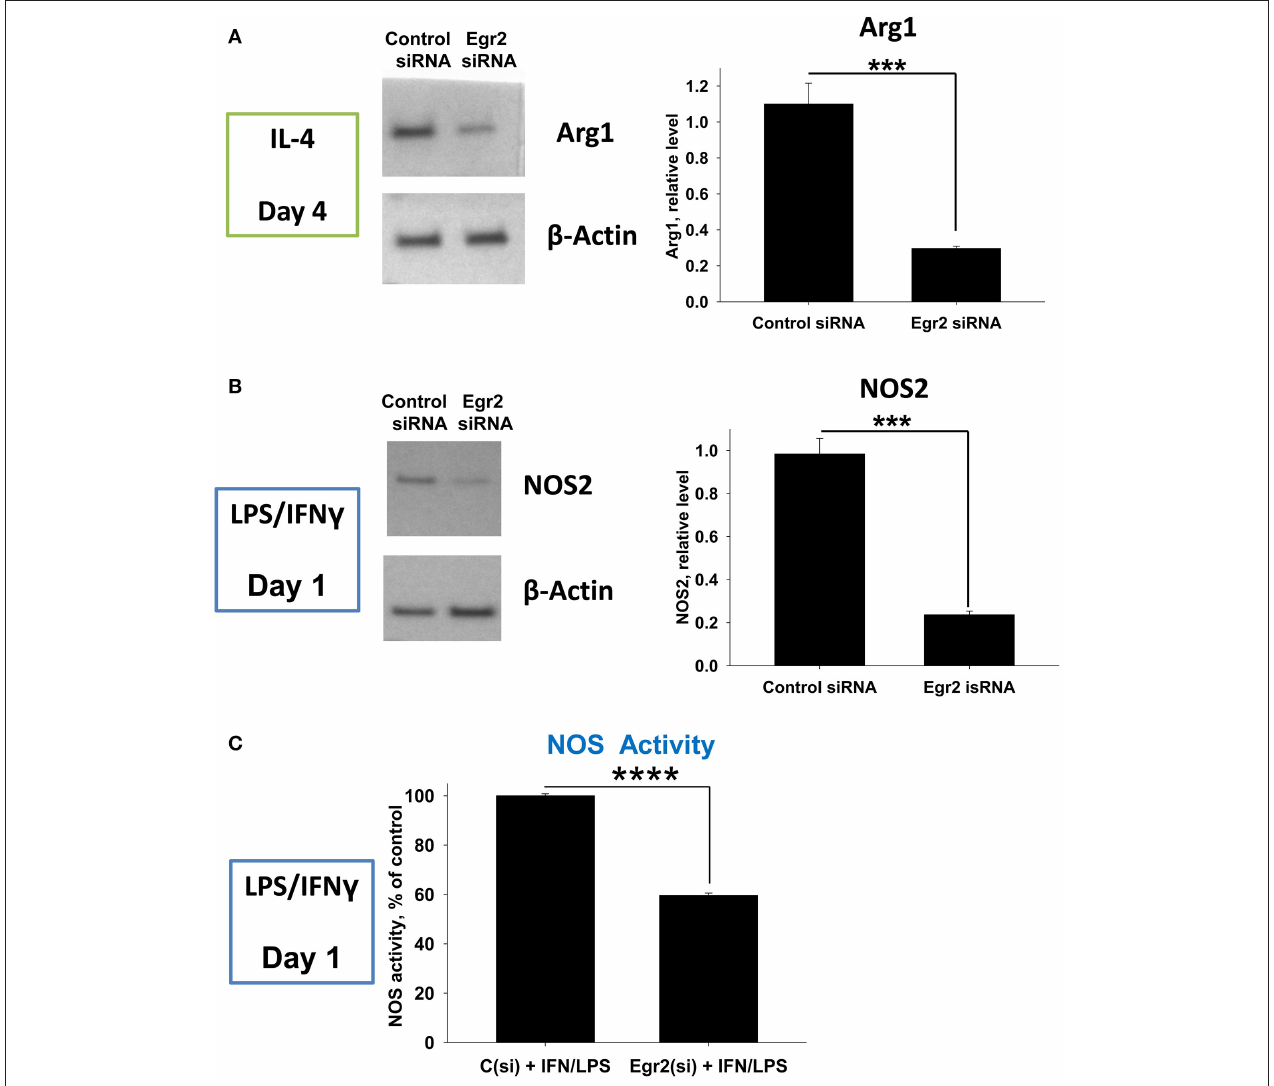
FIGURE 7 | Analysis of the expression of Arg1 on a protein level in M2 macrophages with knockdown of Egr2 and NOS2 protein expression level along with NOS enzymatic activity in M1 macrophages with knockdown of Egr2. Bone-marrow-derived macrophages (BMDMs) were transfected with Egr2 siRNA [Egr2(si)] or Control siRNA [C(si)] for 24h as described in Materials and Methods , and after which the cells were treated with IL-4 or IFN γ /LPS as described in Materials and Methods and the cells were analyzed after 96 or 24h of incubation with IL-4 or IFN γ /LPS, respectively. For the analysis, the cells were washed, and the expression of Arg1 (A) or NOS2 (B) was analyzed on a protein level by western blot as described in Material and Methods . β -Actin has used a loading control. Representative blots are shown on the left and quantitative analysis is shown on the right. NOS enzymatic activity was measured as described in Material and Methods is shown for IFN γ /LPS-treated macrophages transfected with Egr2 siRNA vs. Control siRNA (C) . In (A–C) , mean ± S.E. of quadruplicate is shown. Statistically significant differences in the expression levels with are shown on the figures (*** p < 0.001; **** p <